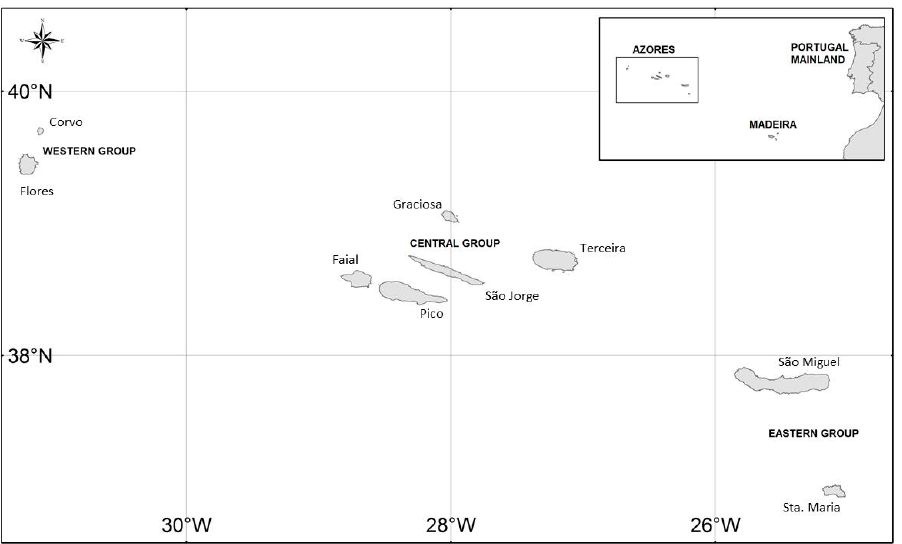
Figure 1. Geographical location of the Azores archipelago in the North Atlantic Ocean. The three main groups of islands are also shown: Western (islands Corvo and Flores), Central (islands Terceira, Pico, Faial, São Jorge and Graciosa) and Eastern (islands São Miguel and Santa Maria) groups.